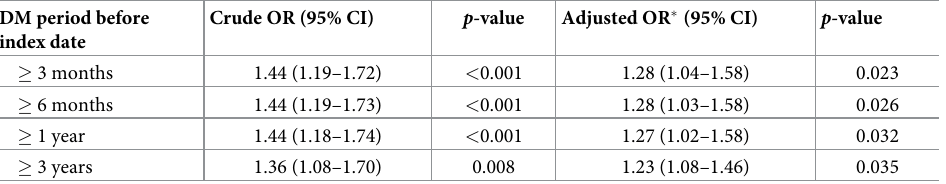
Table 3. Stratified analysis of the association between acute epiglottitis and DM with different definition of preex- isting DM period before the index